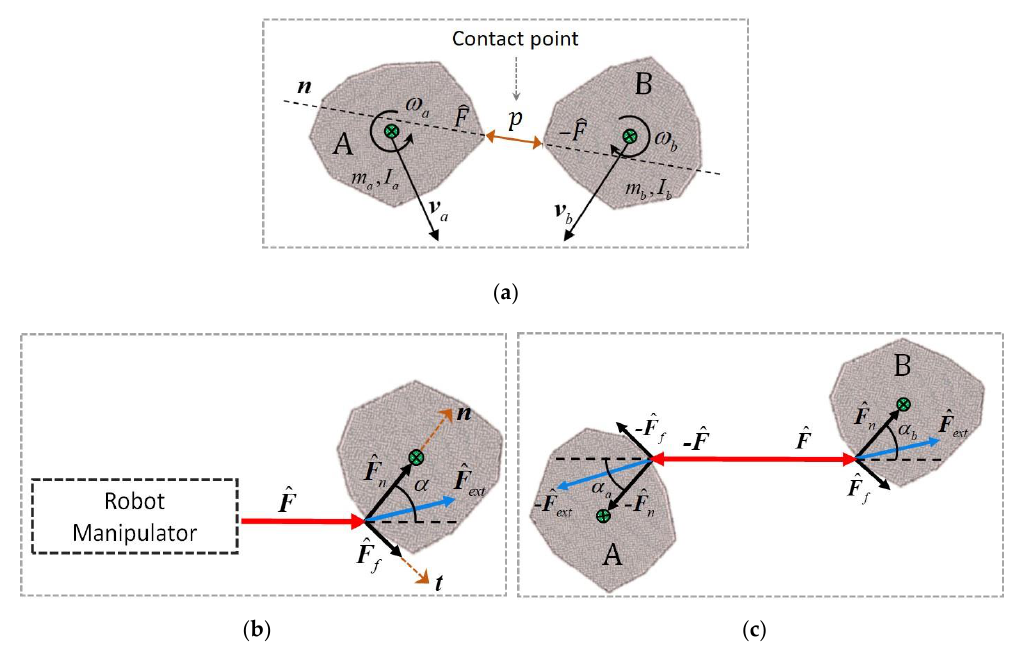
Figure 4. ( a ) Collision model of two translating and rotating bodies. ( b ) Object and manipulator collision model by considering friction. ( c ) Collision model among objects by considering